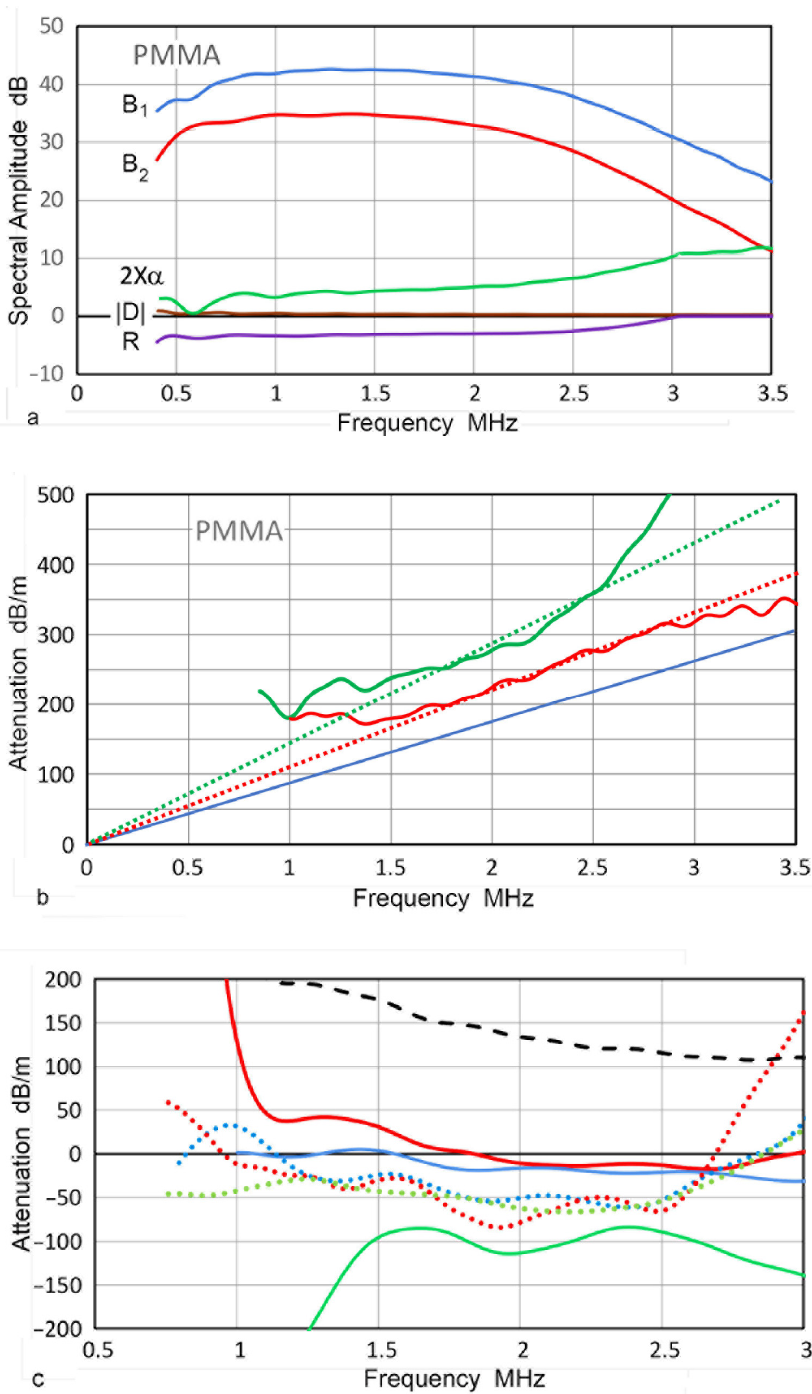
Figure 5. ( a ) Attenuation test by the buffer-rod method for a PMMA sample (9.1 mm thick). B 1 ( f ): blue curve, B 2 ( f ): red curve, |D( f )|: brown curve, R( f ): purple curve, 2Xa: green curve. ( b ) Attenuation in dB/m vs. f . Buffer-rod method: green curve. Two-thickness method using two PE1 pulse-echo signals: red curve. Blue line represents PMMA attenuation from (Adapted from Ref. [43]). Green and red dotted lines are fitted to the slope of green and red curves. ( c ) Attenuation in dB/m obtained using the C1332 procedure for seven samples. Pyrex glass: blue curve, Fused silica: red, soda-lime glass: green, hardened steel: blue dotted, 360 brass: red dotted, Beta-III titanium: green dotted, PVC: black dashed (attenuation was reduced by a factor of